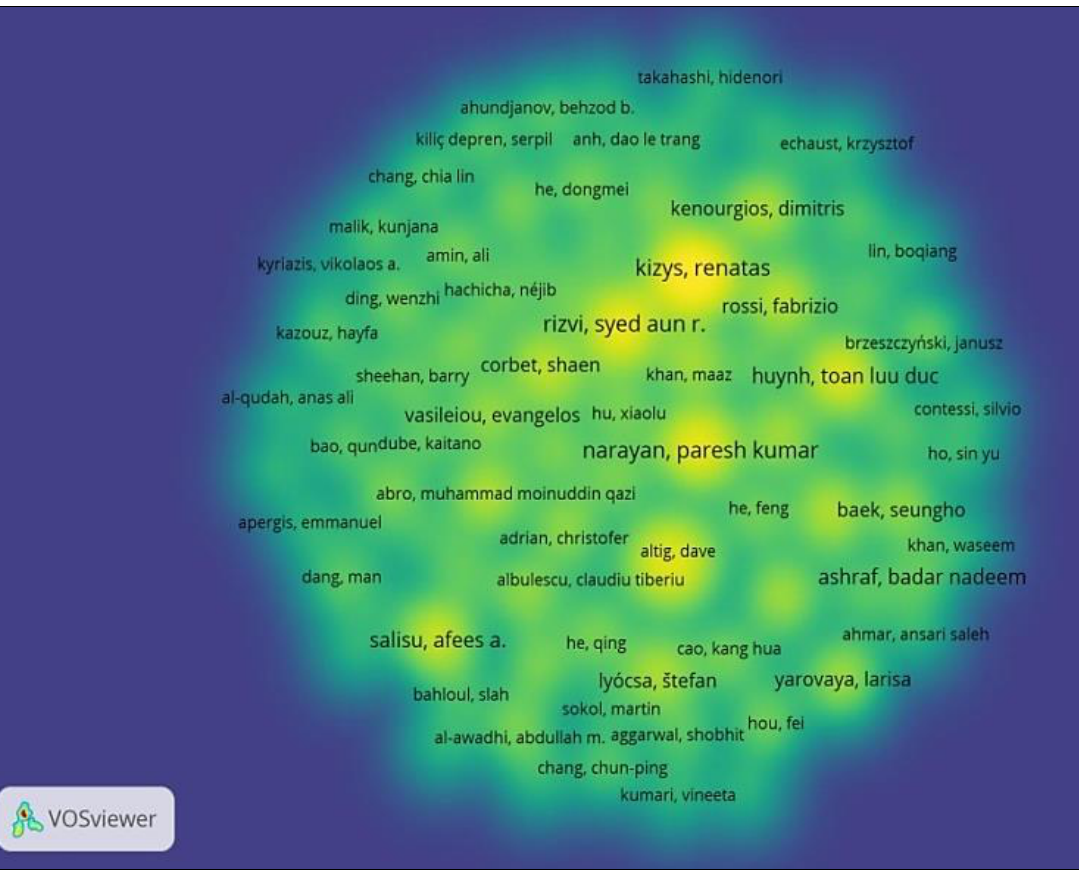
Figure 5. Item Density Visualization (Authors)